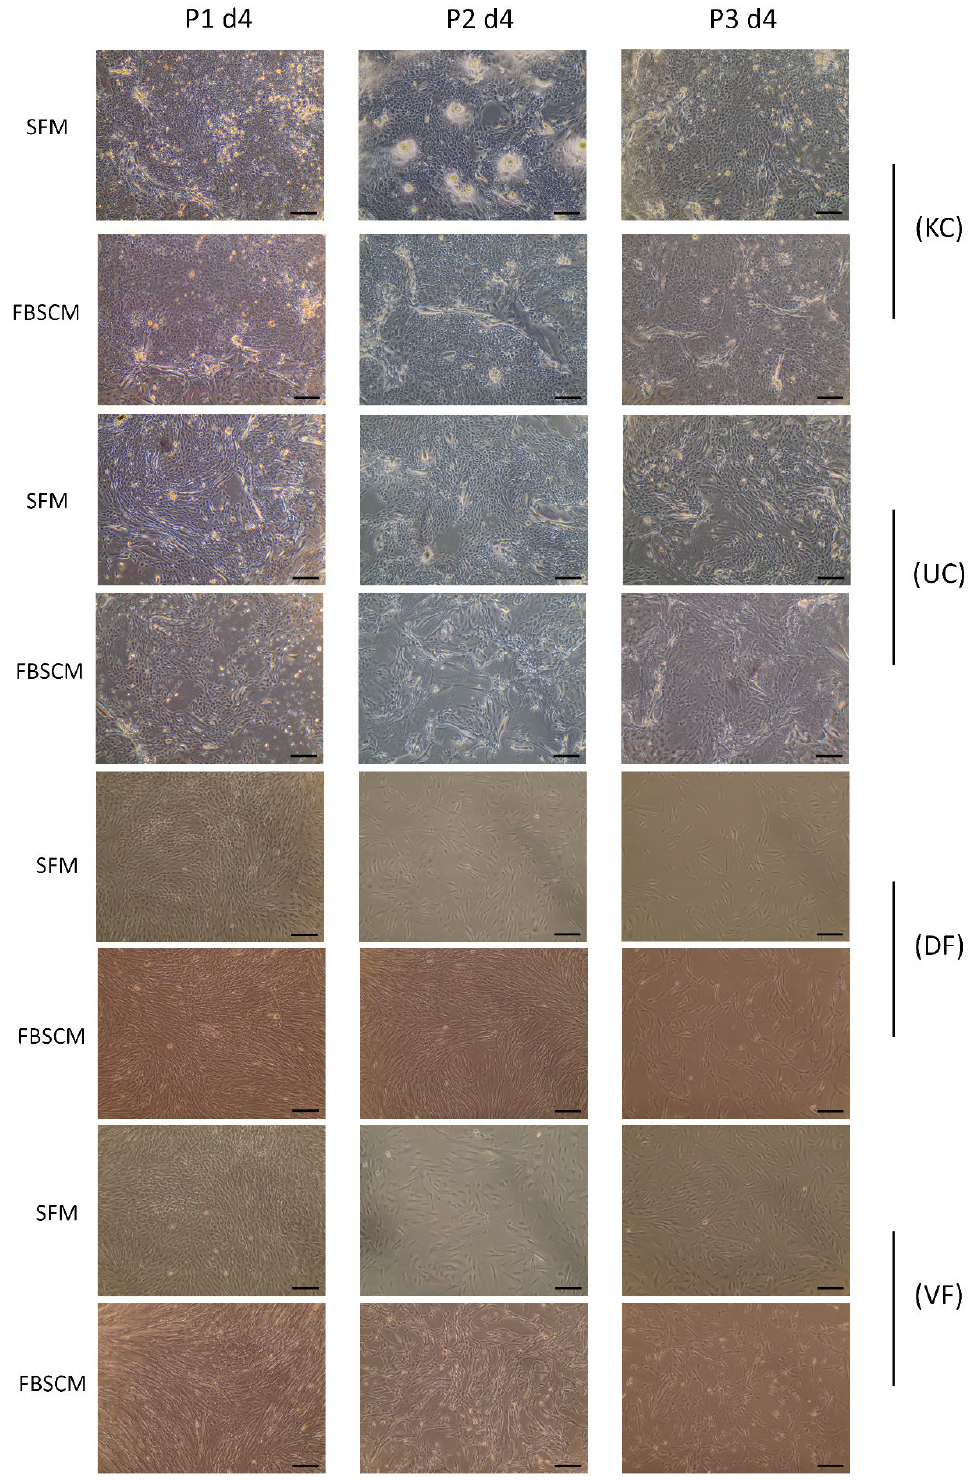
Figure 1. Morphology of epithelial and stromal cells at passages 1, 2 and 3. (KC) Morphology of keratinocytes, (UC) Morphology of urothelial cells, (DF) Morphology of dermal fibroblasts and (VF) Morphology of vesical fibroblasts after four days (P1 d4: passage one, day 4), 11 days (P2 d4: passage two, day 4) and 18 days (P3 d4: passage three, day 4) of culture in serum-free medium or fetal bovine serum-containing medium. Experiments were performed in triplicate for each cell population; a representative image is shown. The images were captured at 10× magnification. Scale bars = 100 µm.